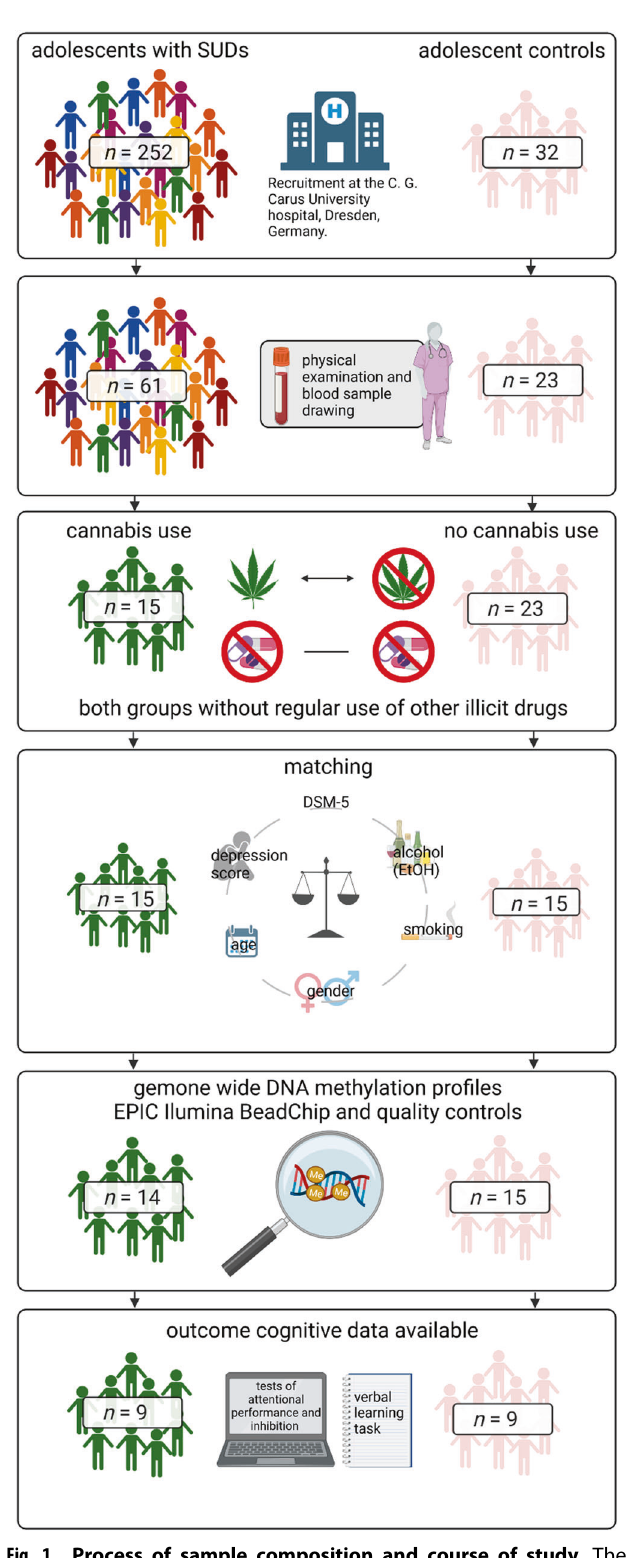
Fig. 1 Process of sample composition and course of study. The fi gure was created with